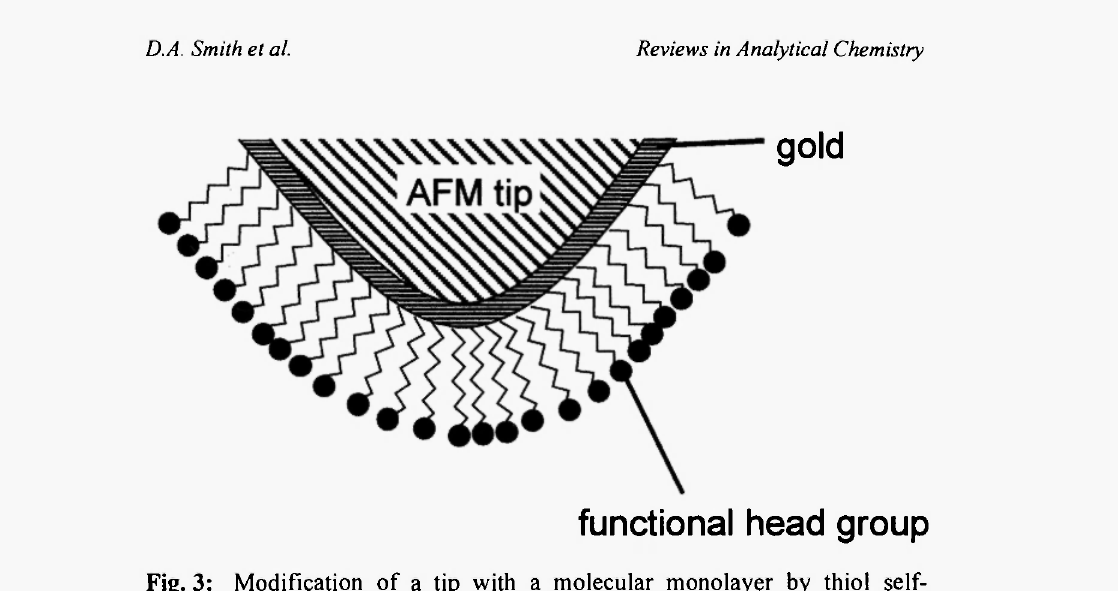
Fig. 3: Modification of a tip with a molecular monolayer by thiol self- assembly. ω-functionalised alkyl thiols are typically used which spontaneously form a monolayer at the surface of a gold film which can be applied by thermal evaporation or sputtering to a tip or glass substrate. The functional group (shown schematically as a solid circle) then provides the new chemical functionality of the